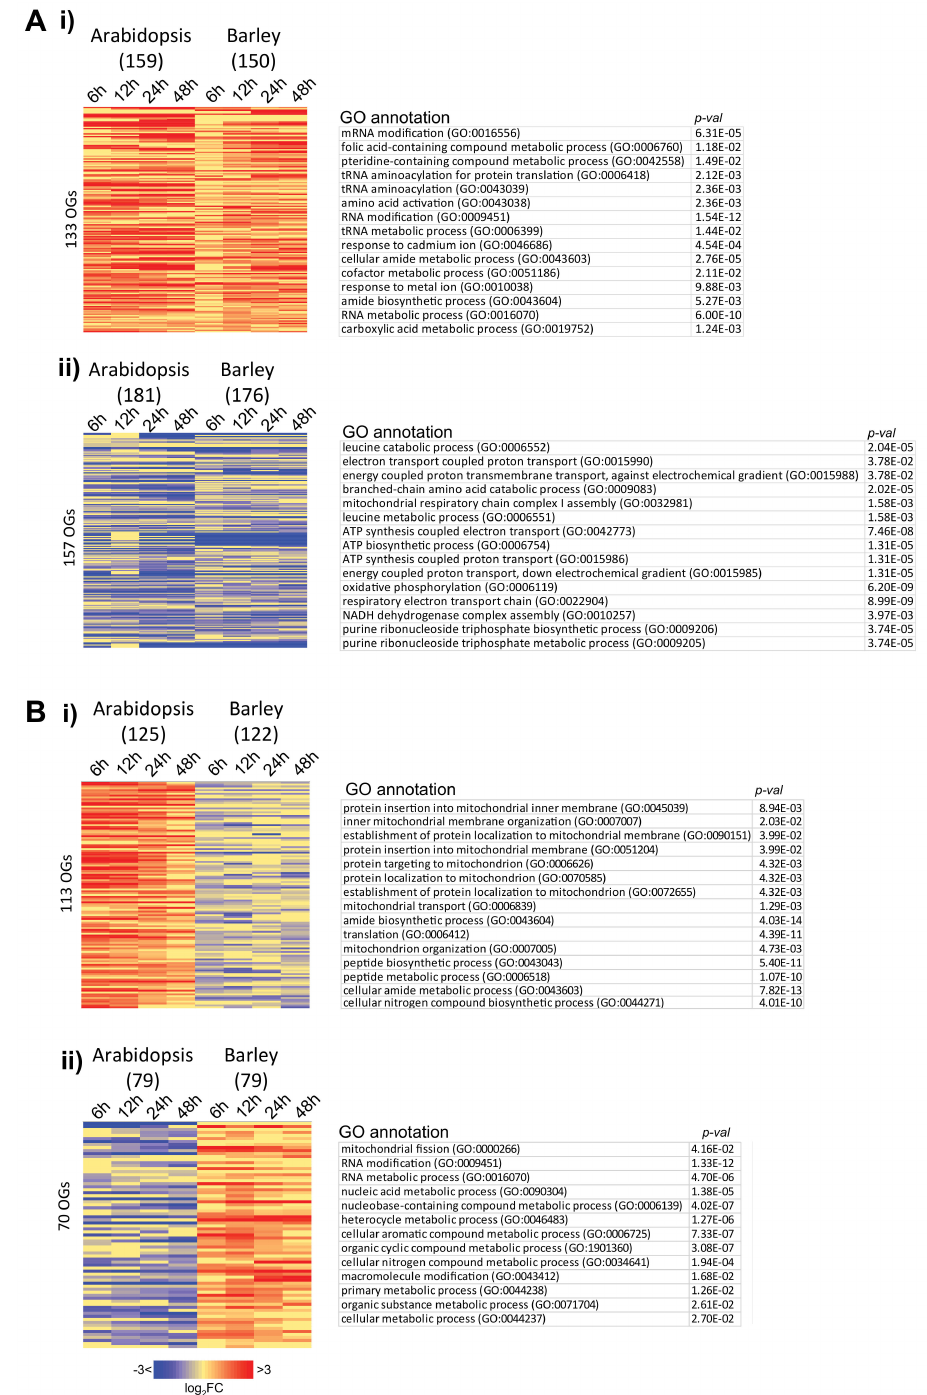
Figure 10. Analysis of genes encoding orthologous mitochondrial proteins that are responsive during germination in barley and Arabidopsis. ( A ) Heatmap showing the orthologous genes that showed conserved responses to germination in barley and Arabidopsis, with (i) conserved upregulated genes and (ii) conserved downregulated gene sets shown. The top 15 gene ontology-enriched categories are shown next to these ( p < 0.05, Bonferroni). ( B ) Heatmaps showing orthologous genes that showed distinct responses to germination in barley and Arabidopsis, with (i) upregulated genes in Arabidopsis orthologous to downregulated genes in barley shown, and (ii) downregulated genes in Arabidopsis orthologous to upregulated genes in barley shown. The top 15 gene ontology (GO)-enriched categories are shown next to these ( p < 0.05,